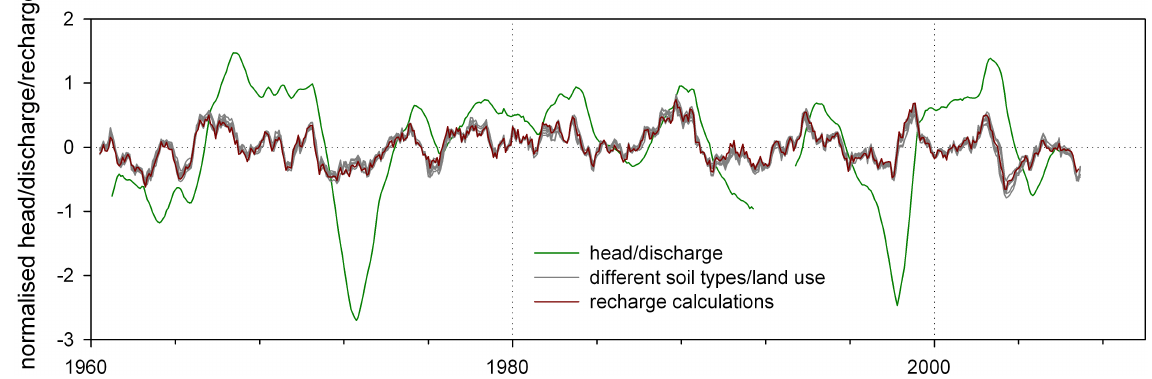
Fig. 7. Normalized monthly recharge sums for eight different model combinations (grey), the result from the original model setup (red) and the observed normalized groundwater level (green) at the observation site Niederstotzingen (14).